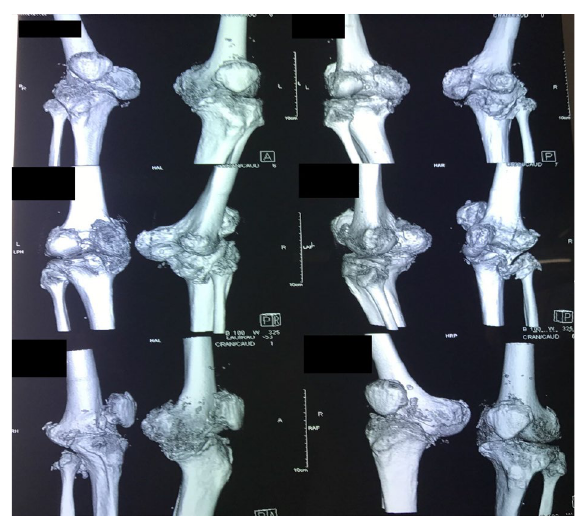
Figure 4 . 3D Reconstruction CT scan of Bilateral